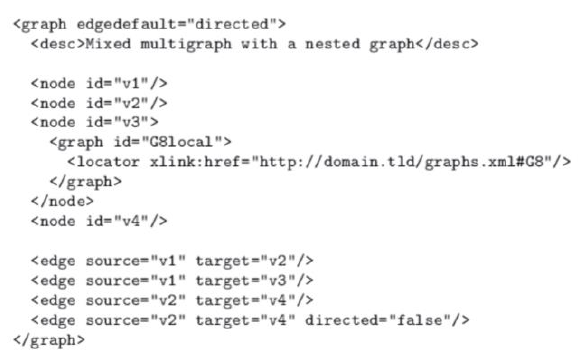
Figure 2. A GraphML representation of a nested graph (Brandes et al., 2002, p.